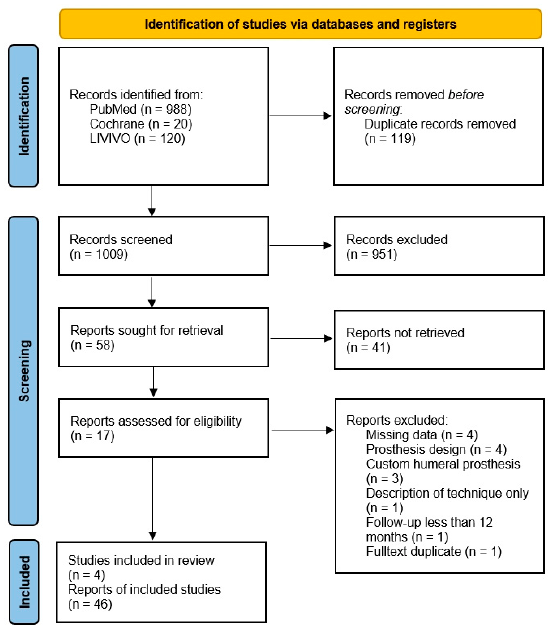
Figure 1. PRISMA Flow Diagram. Created according to the PRISMA guidelines [10].